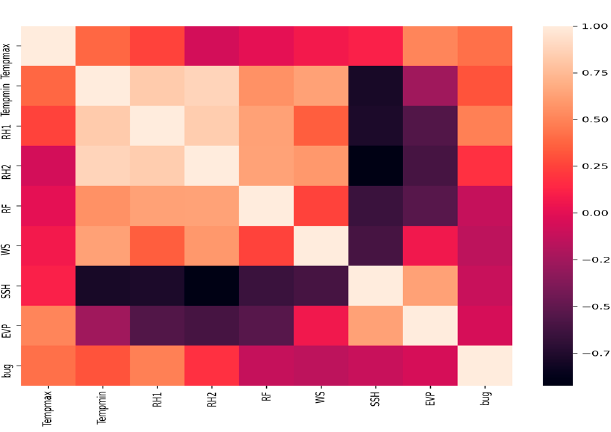
Figure 9. Heat map of the correlation coefficients for Experiment 2.